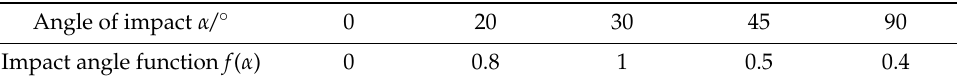
Table 1. Impact angle function